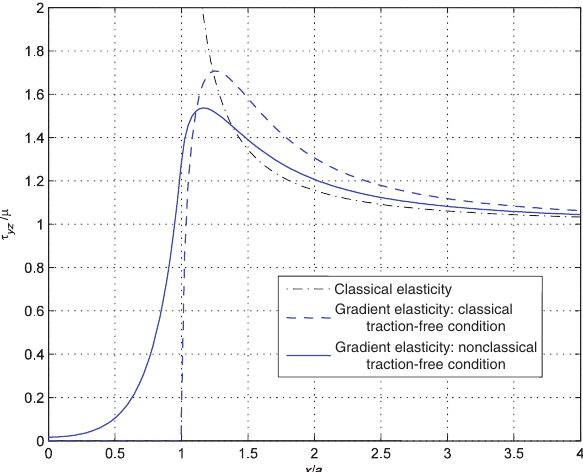
for classical and nonclassical traction-free Figure 6: Stress τ yz conditions in gradient theory compared to the one in classical elasticity, ℓ = 0.2 a .